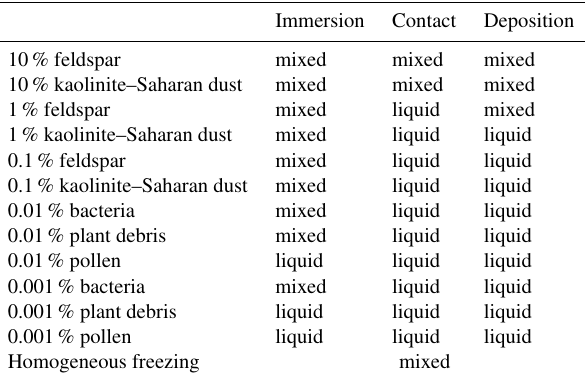
Table 2. List of simulated cases with single freezing modes result- ing in mixed-phase or liquid clouds. Immersion Contact